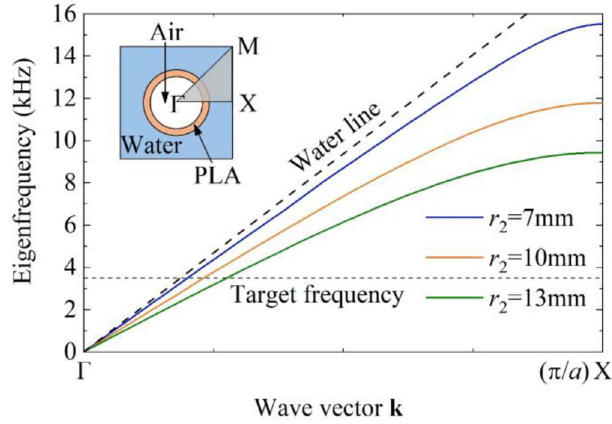
Figure 1. Band structures in C (cid:1) X direction of the PLA-Air phononic crystals with different scatterer ’ s radii, r 2 = 7, 10 and 13